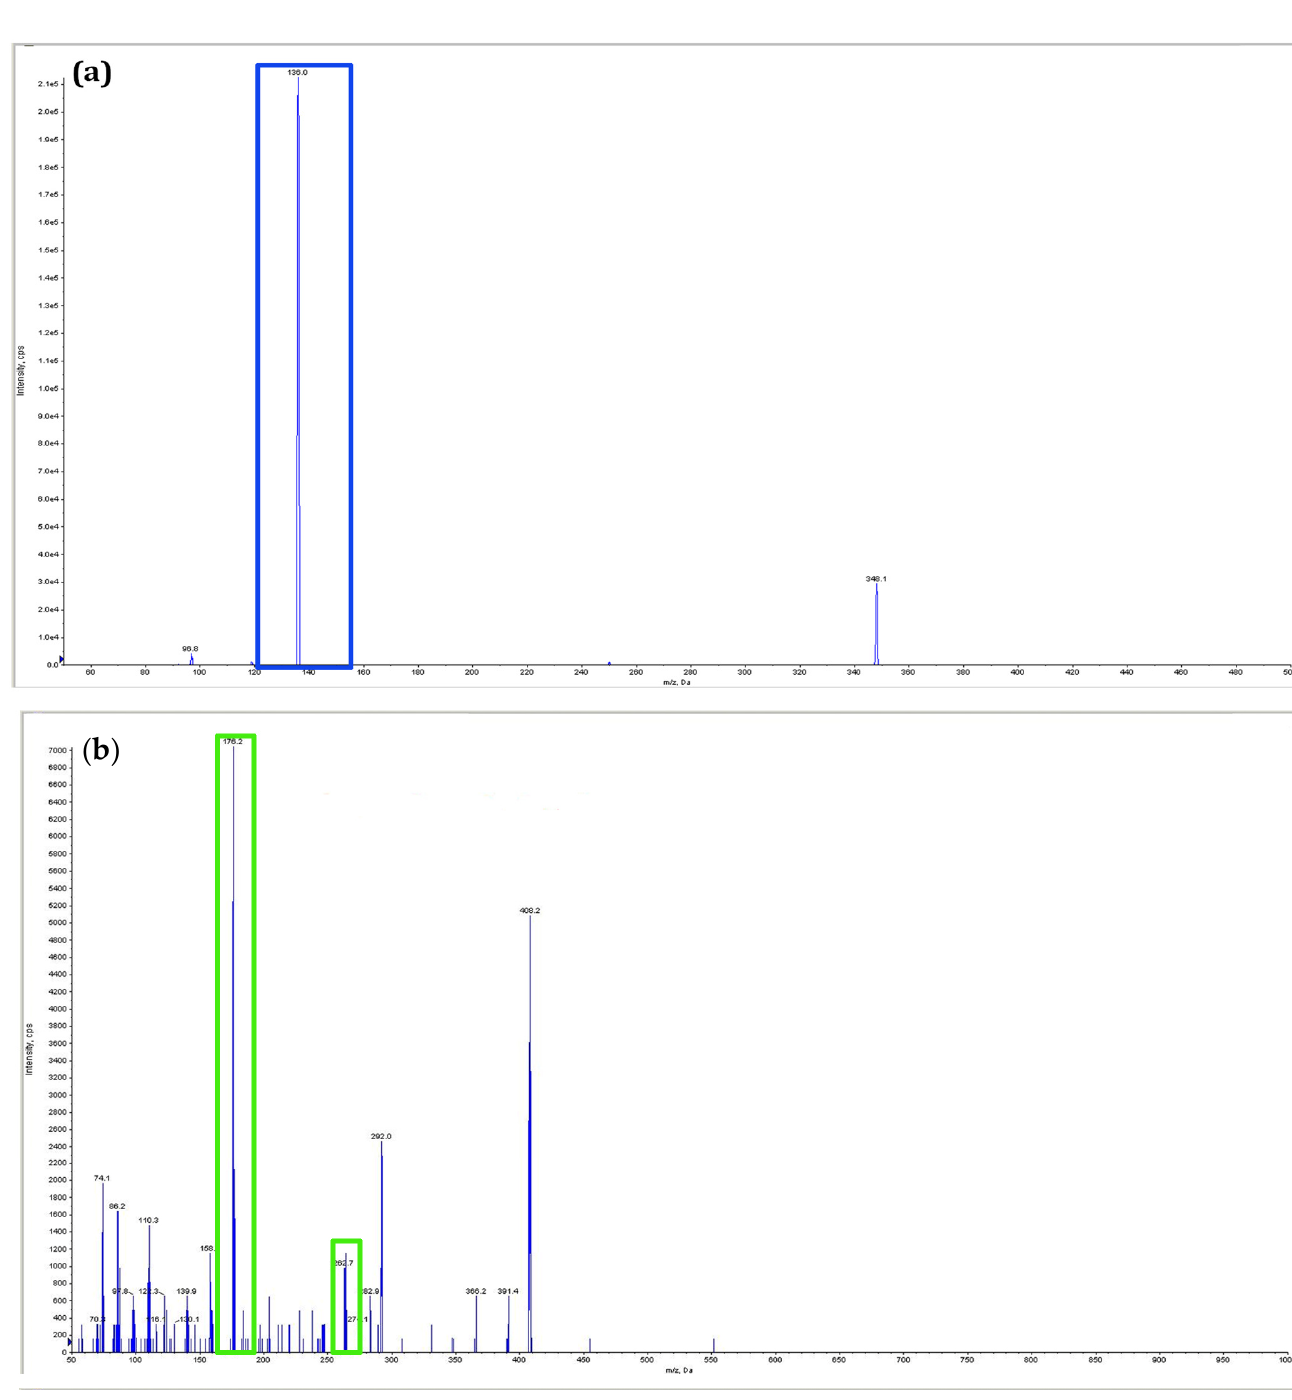
Figure 4. Retention analysis in HPLC: ( a ) elution chromatogram of ATP; time interval: 2.3 to 3.3. ( b ) Elution chromatogram of streptomycin; time interval: 2.0 to 2.50. ( c ). Elution chromatogram of ade- nylated streptomycin; time interval: 2.40 to 3.30.